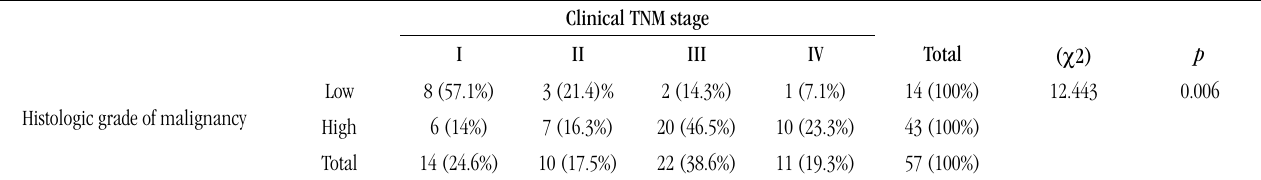
tABLE 3 – Correlation between histological grade and clinical TNM stage. Significance level according to chi-square test ( χ